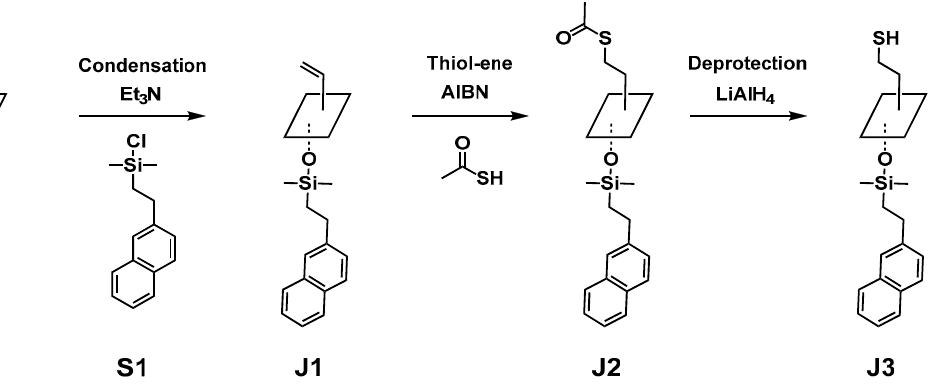
Figure 4. Synthetic route to the bifunctional Janus T 4 tetrapod (note that refers to the Si 4 O 4 ring,